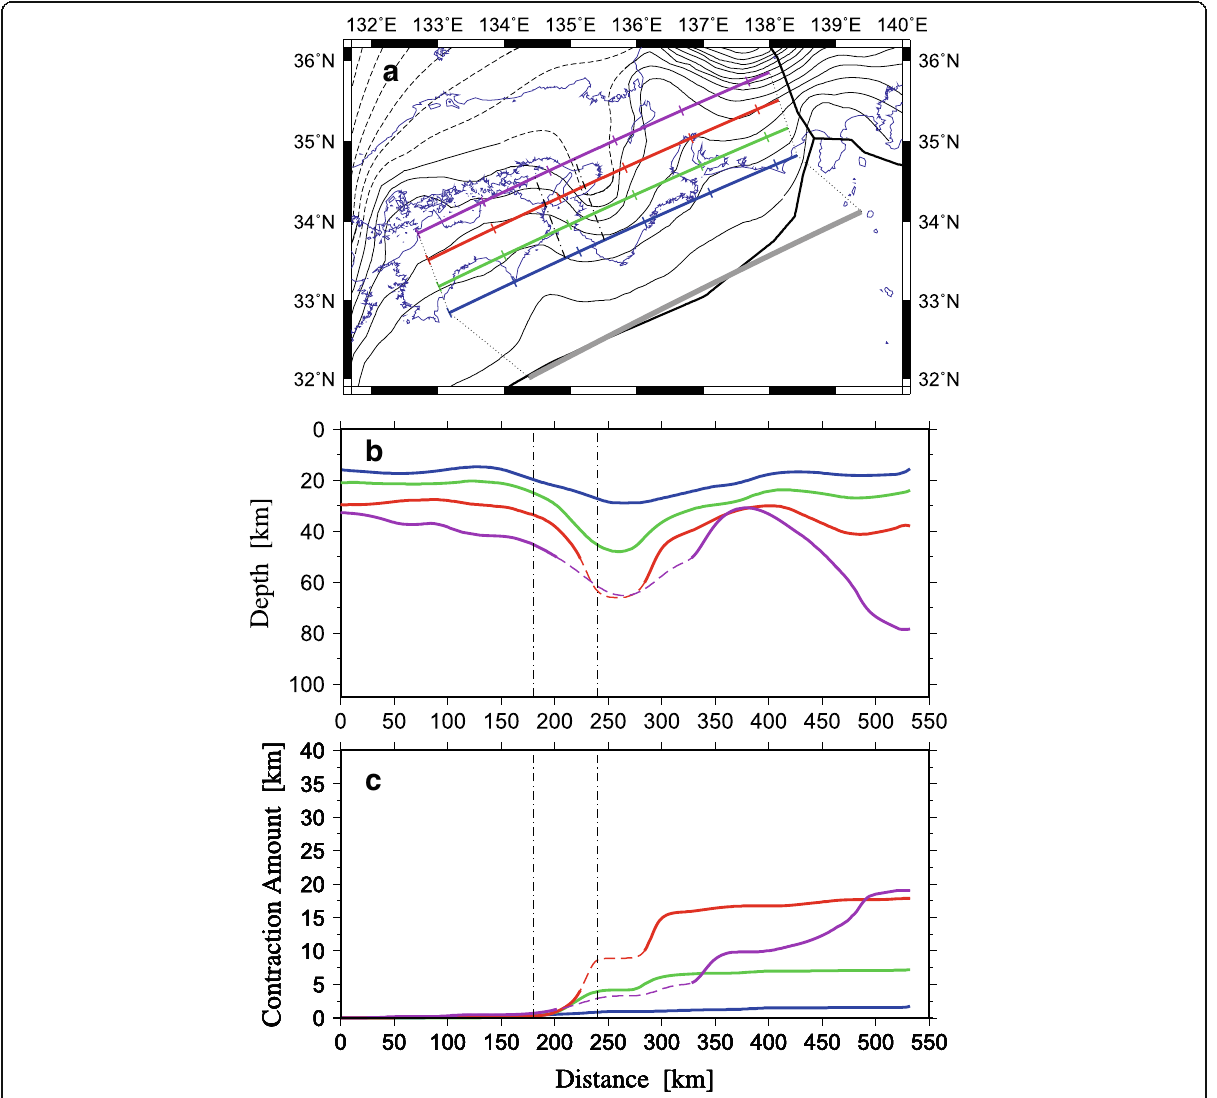
Fig. 3 The same as Fig. 2, but the Hirose model (Hirose et al. 2008a) is used for the configuration of the PHS slab. The following results are also used for the plate configuration model: Baba et al. (2002), Nakajima and Hasegawa (2007), Hirose et al. (2008b), and Nakajima et al.